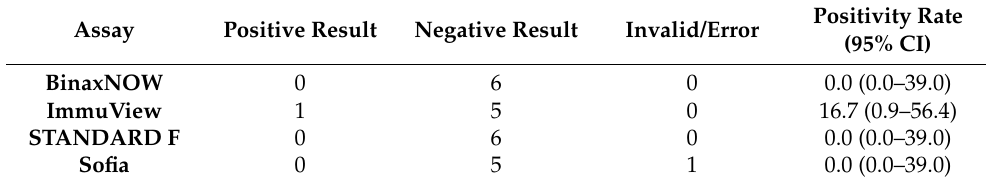
Table 2. Positivity of four Legionella urine antigen assays on samples from patients with PCR- confirmed Legionella infection by species other than Legionella pneumophila serogroup 1 *.